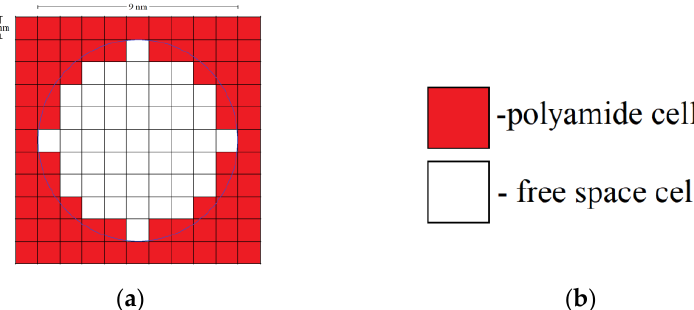
Figure 17. Two-dimensional pore with a diameter of 9 nm ( a ); types of cells in the developed model of the carbon aerogel structure ( b ).